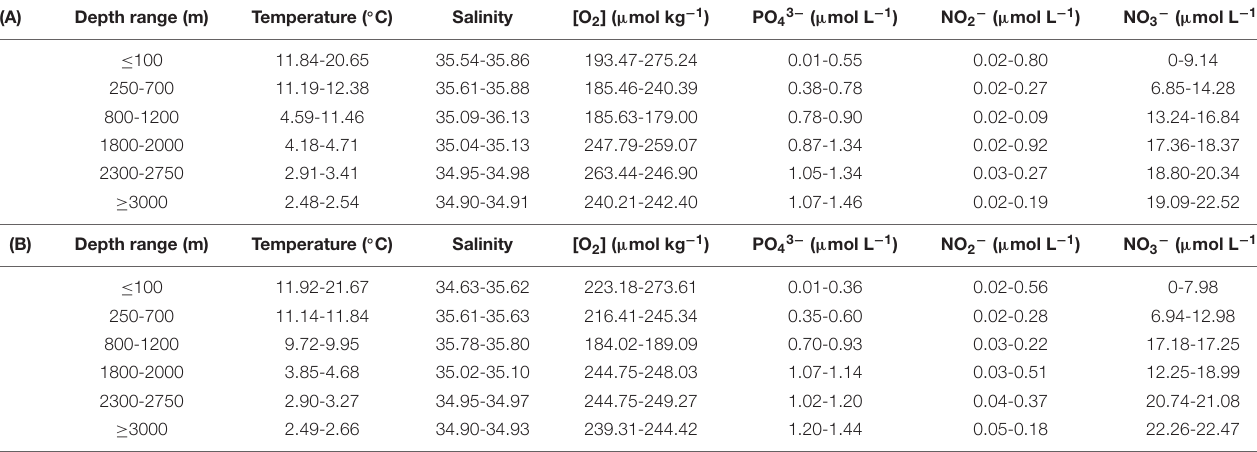
TABLE 1 | Range of variability (minimum-maximum) of the hydrographic features at the different sampling depth ranges during MODUPLAN cruise along (A) Fisterra and (B) Santander sections. Depth range